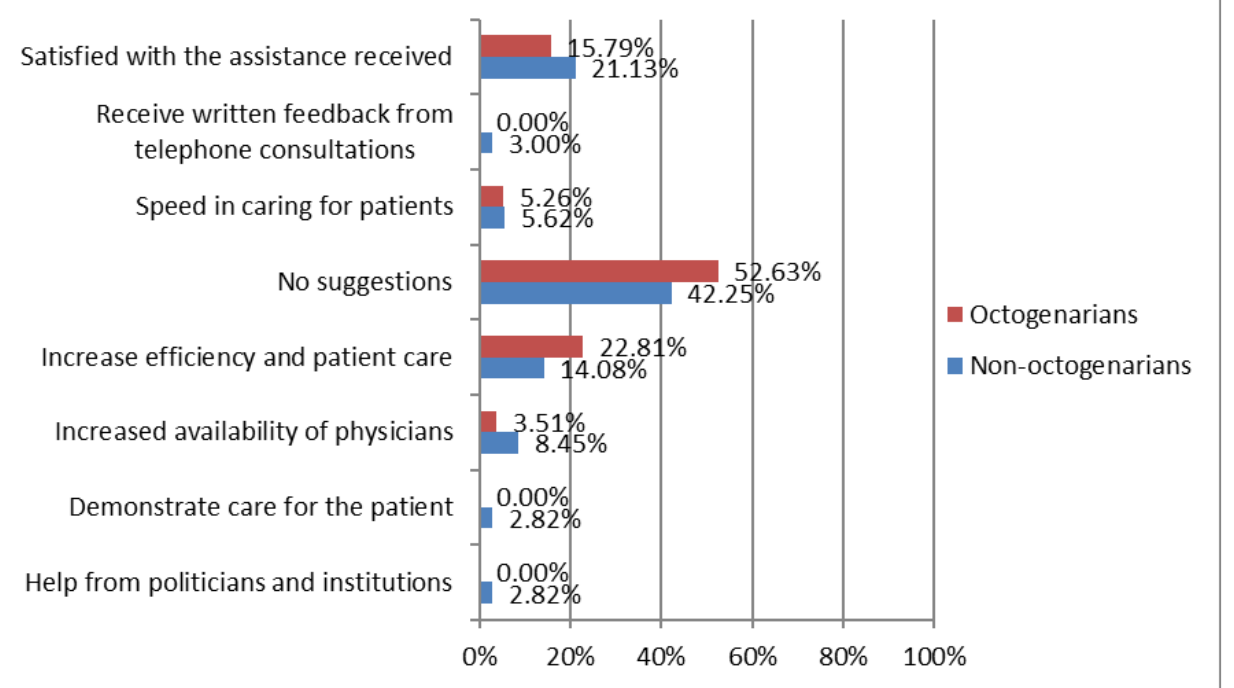
Figure 5. Differences between octogenarians vs. non-octogenarians in suggestions to improve care during COVID- 19 confinement. Octogenarians (≥80 years; n = 53). Non-octogenarians (<80 years; n = 67).